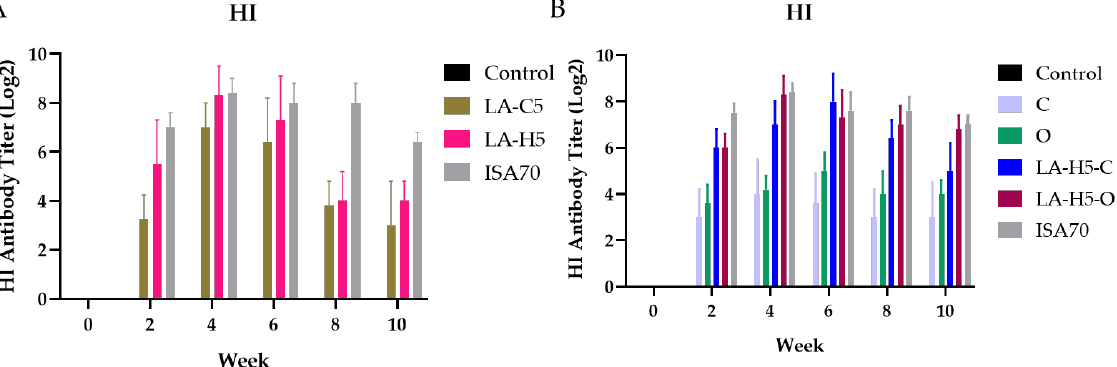
Figure 3. Antibody titer from hemagglutinin inhibition assay (HI) with designated adjuvants of ( A ) primary immunization and ( B ) secondary immunization. Control: no vaccination. LA-C5: 0.5 U LA particles. LA-H5: 0.5 U LA particles with trehalose and emulsifiers. ISA70: Montanide ISA70 W/O adjuvant. LA-H5: *, ISA70: ** (compared with control) in Figure 3A; LA-H5-C: **, LA-H5-O: **, ISA70: ** (compared with control) in Figure 3B. *: p < 0.05, **: p < 0.01. Data are presented as the mean ± SEM and determined by one-way ANOVA using Tukey’s posttest.